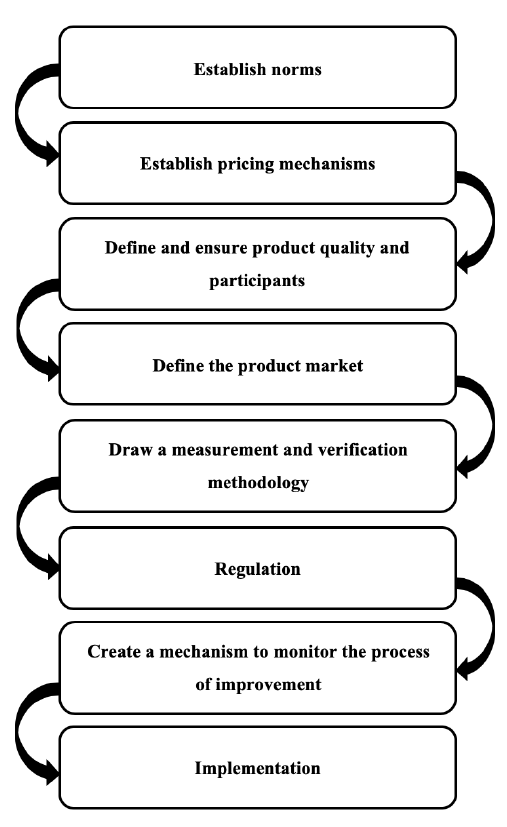
Figure 2. Steps to create the